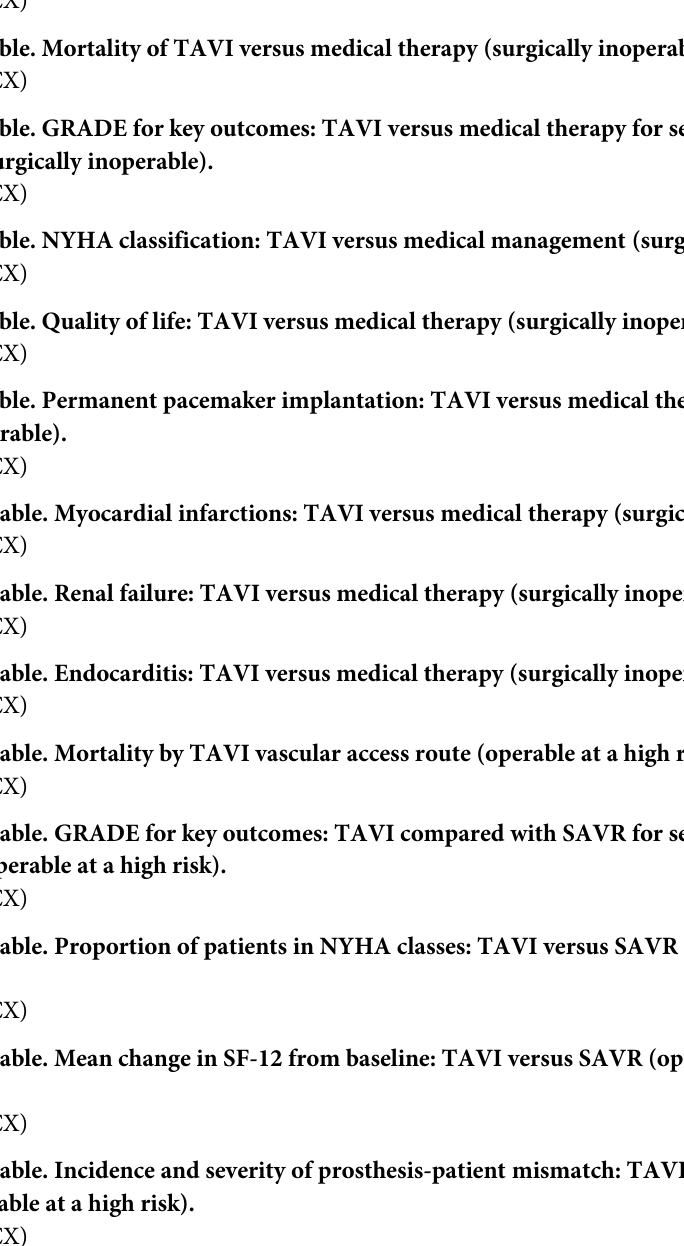
S14 Table. GRADE for key outcomes: TAVI compared with SAVR for severe aortic steno- sis (operable at a high risk). S15 Table. Proportion of patients in NYHA classes: TAVI versus SAVR (operable at a high risk). S16 Table. Mean change in SF-12 from baseline: TAVI versus SAVR (operable at a high risk). S17 Table. Incidence and severity of prosthesis-patient mismatch: TAVI versus SAVR (operable at a high